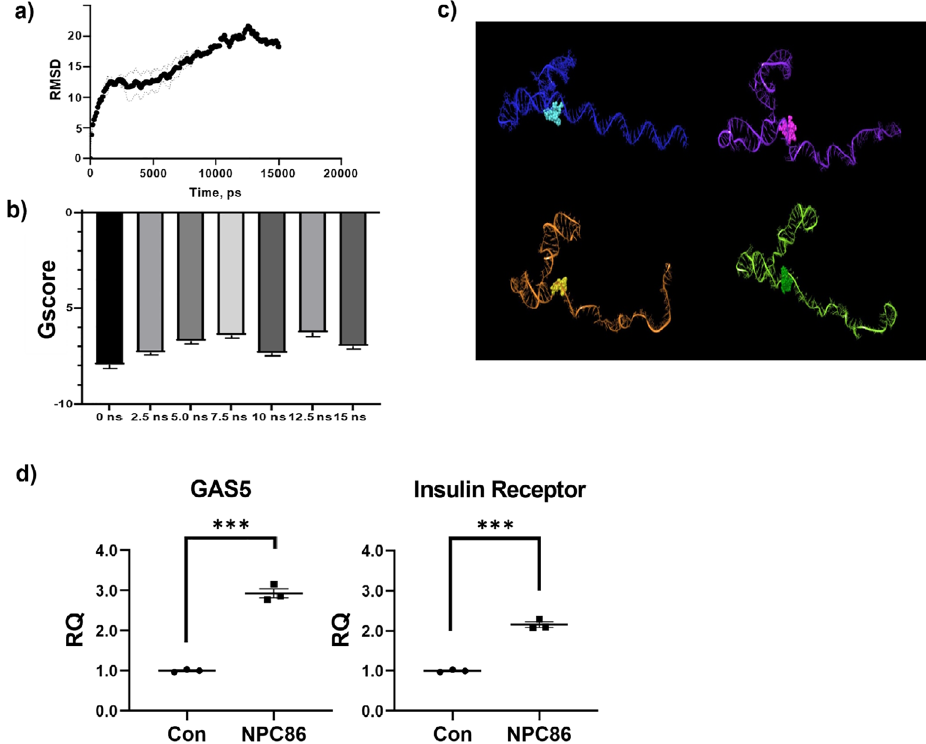
Figure 3. ( a ) RMSD over the course of molecular dynamics equilibration simulations of 10 and 15 ns taken from backbone of RNA structure to the first starting pose show conformation stabilization between 2.5 and 7.5 ns. ( b ) Gscore analysis demonstrates docking of NPC86 to GAS5 transcript using Schrodinger Glide SP showing a lowered predicted affinity during the transition from 0–7.5 ns. ( c ) Slices of the docking